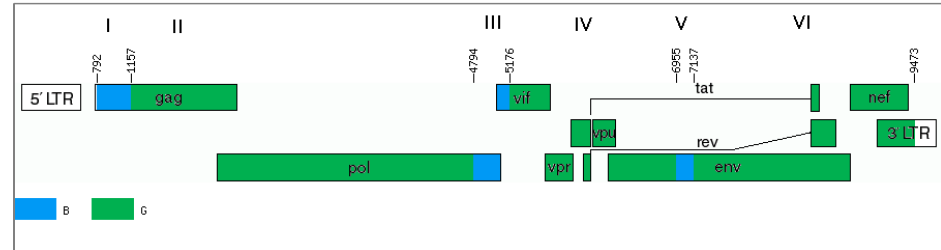
Figure 4. The mosaic structure of the new BG-recombinant form. The regions are numbered according to the jpHMM program. Areas III and V are subtype B or uncertain regions. The patterns of homology are shown as follows: the G subtype is highlighted in green and the B subtype is highlighted in blue.